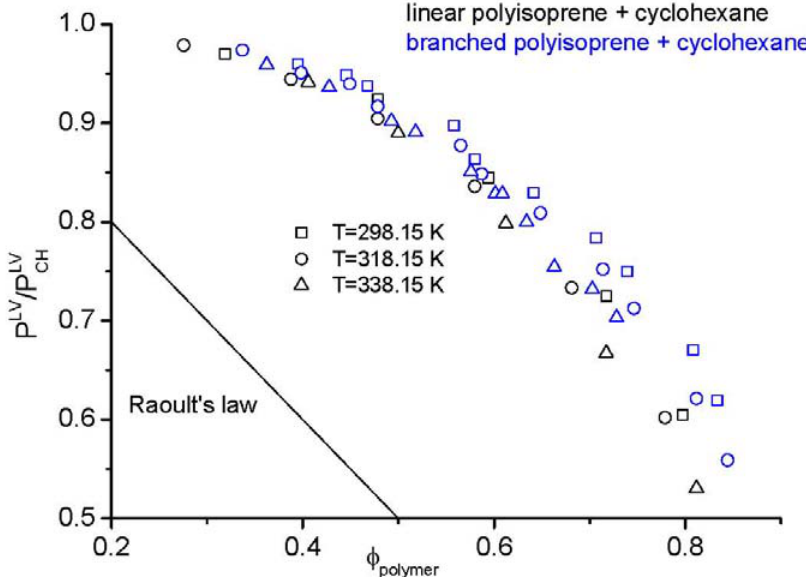
Figure 1. Vapour Pressure of polymer solutions , divided by the vapour pressure of the pure solvent , made from linear (black symbols) or branched (blue symbols) polyisoprene and cyclohexane [61].